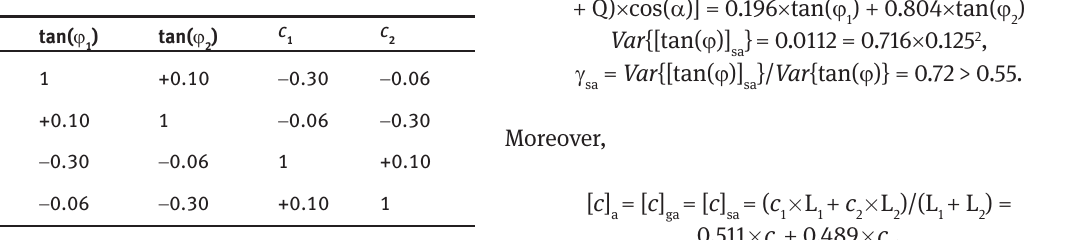
Table 2: Auto- and crosscorrelation coefficients used in numerical